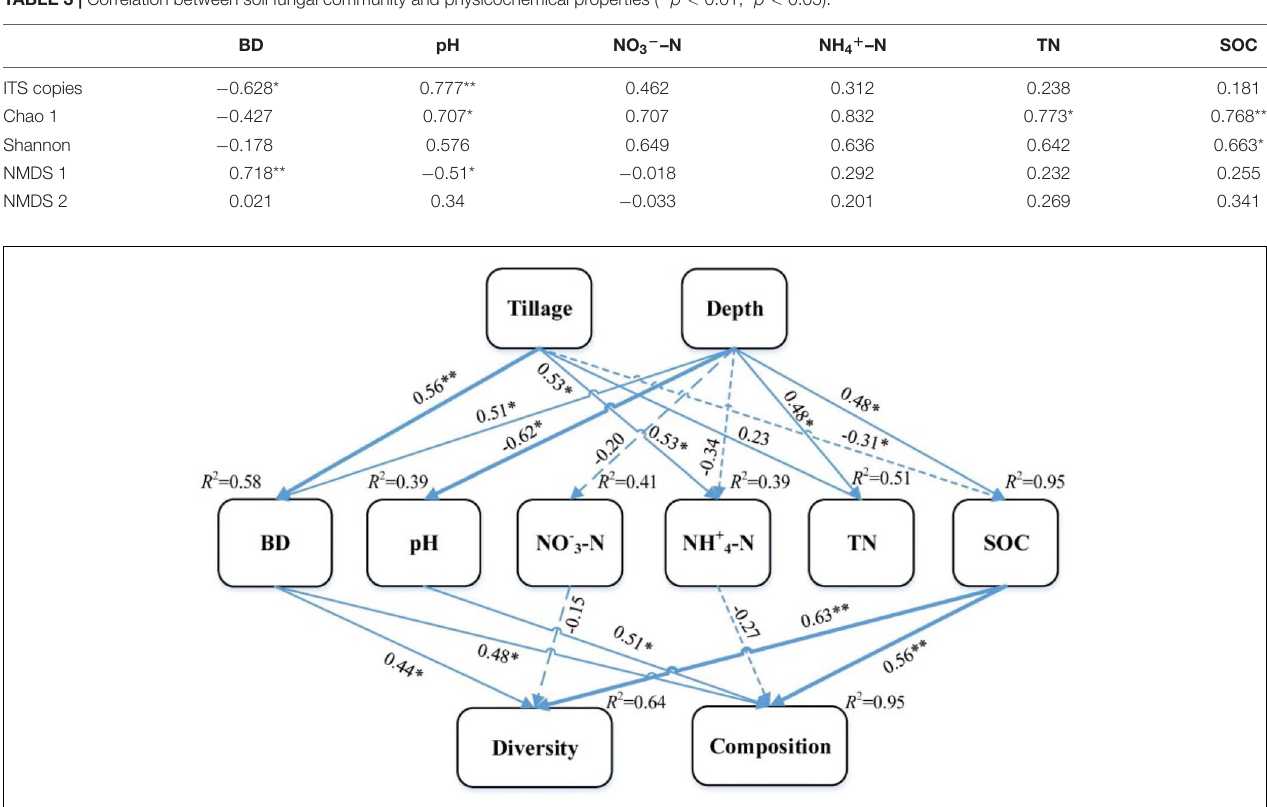
FIGURE 5 | Structure equation models examining the effects of tillage and depth on soil fungal communities. SOC, soil organic carbon; TN, total nitrogen, NO − 3 –N and NH + 4 –N, soil N availability; BD, soil bulk density. A dashed line is a negative relationship and a solid line shows a positive relationship. Numbers above the arrows are standardized path coefficients. The arrow’s width is proportional to the strength of the relationship ( ∗∗ p < 0.01; ∗ p < 0.05).